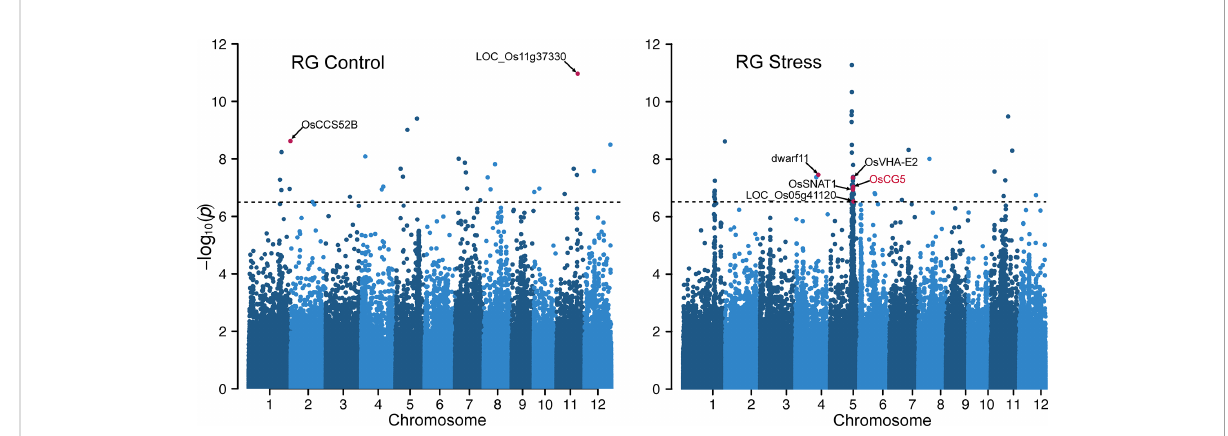
FIGURE 2 Manhattan plots of genome-wide association studies for the ratio of grain R and G pixel intensity values under control and heat stress. The black dotted horizontal line represents the genome- wide signi fi cance threshold ( – log10( P ) > 6.5). SNPs associated with signi fi cant genes are